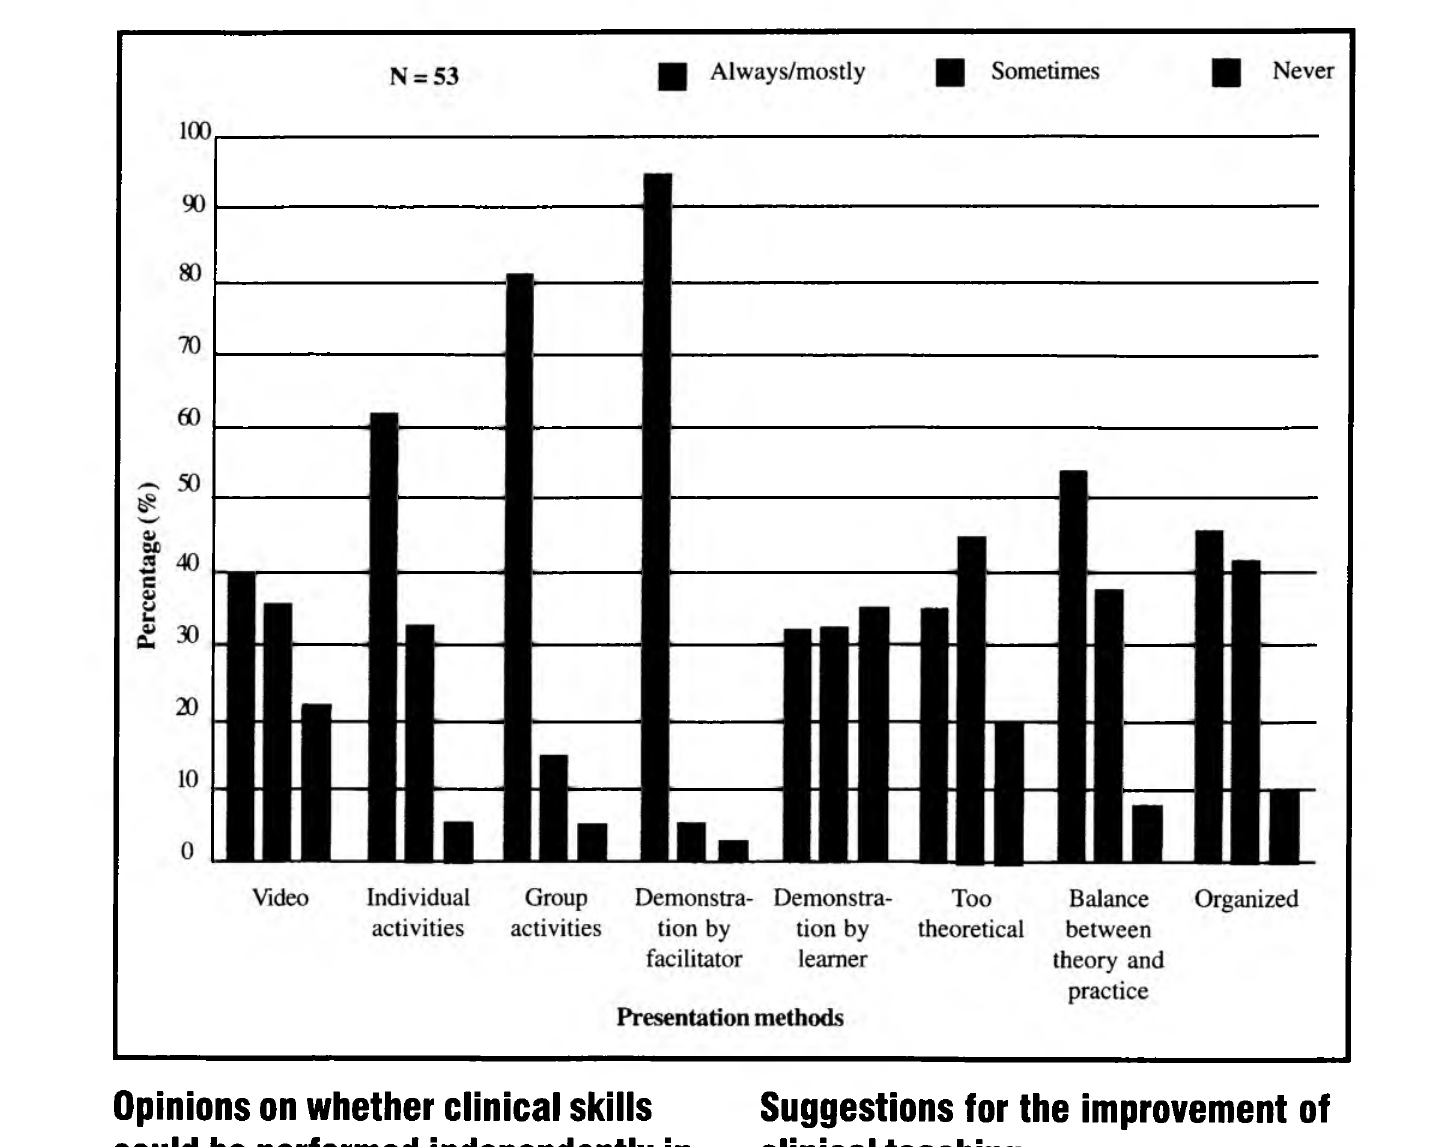
Figure 2: Preferred presentation methods for formal clinical